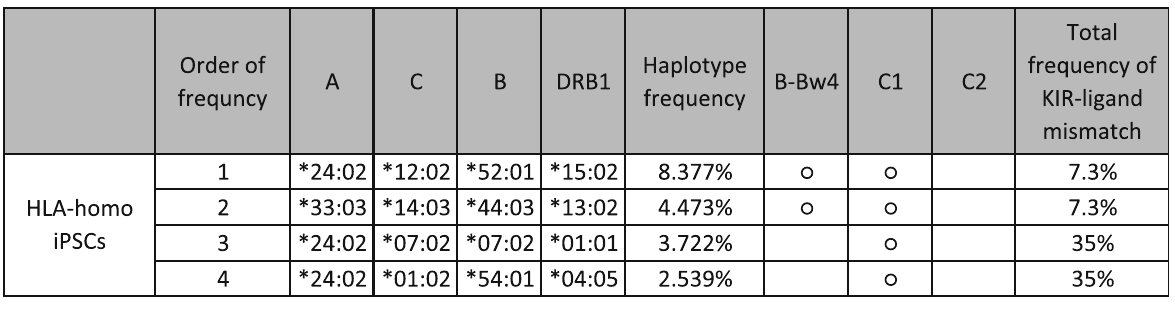
Table 1 Top 4 HLA haplotype frequencies in the Japanese population and the frequencies of occurrence of a KIR-ligand mismatch